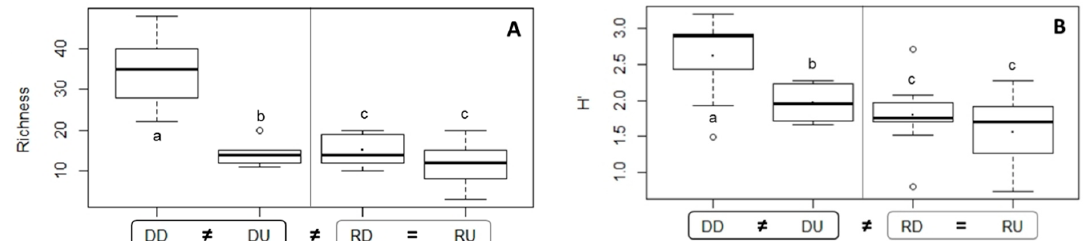
Figure 3. Box and whisker plots and mean values (.) for heavy metals including Fe ( A ), Cu ( B ), Cr ( C ), Hg ( D ), Se ( E ), Pb ( F ), As ( G ), Cd ( H ), H 2 S ( I ) and CH 4 ( J ) concentration in sediment of the estuarine sections. point to estuary level. Abbreviations: “DD” = dammed downstream, “DU” = dammed upstream, “RD” = reference downstream, “RU” = reference upstream. Letters a, b and c refer to signi fi cant di ff erences. “ ≠ ” sign indicated for the significant differences between 2 estuaries or/and estuarine sections within an estuary, while “=” sign meant that no significant difference was found.